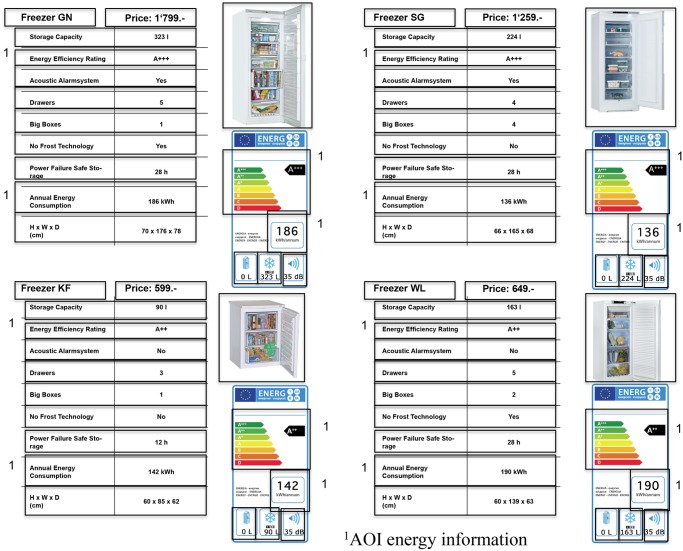
Areas of interest (AOI) defined for the freezer task in the label condition.Each box represents an AOI used for data analysis. The AOIs marked with number 1 were combined with the AOI energy information.